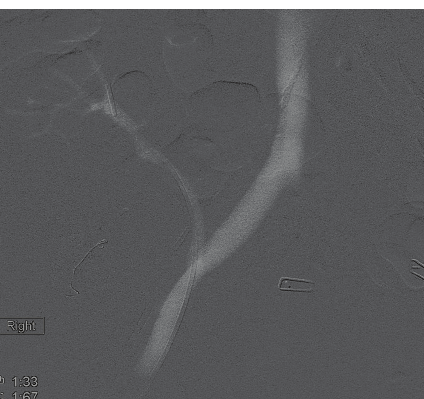
Figure 1: CO 2 angiogram showed high-grade stenosis of renal transplant vein.